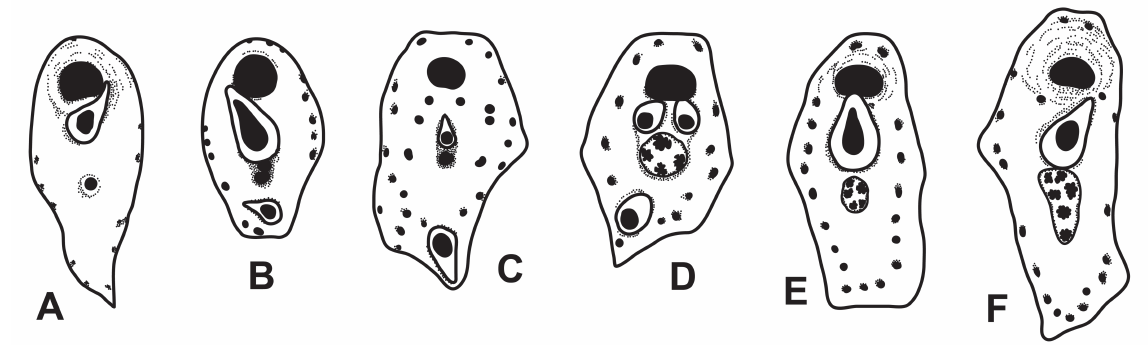
Fig. 17. Schematic drawings of autozooids for the six species of Adeonellopsis MacGillivray, 1886 in Japan. A . A. arculifera (Canu & Bassler, 1929). B . A. japonica (ortmann, 1890). C . A.